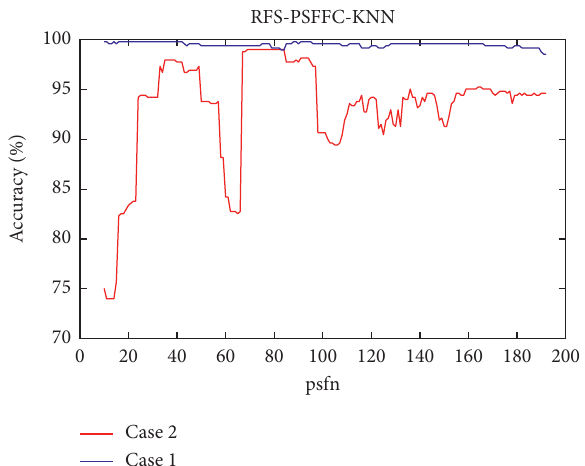
Figure 15: The testing accuracies of RFS-PSFFC-KNN with different psfn values.